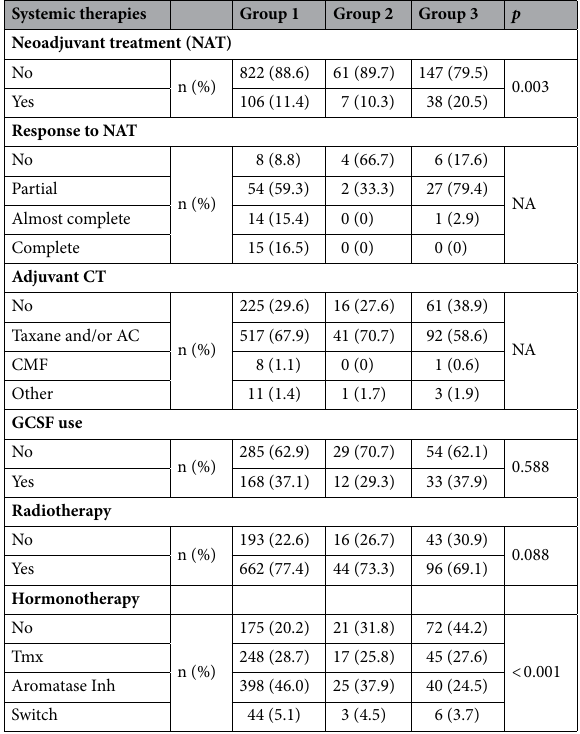
Table 3. Adjuvant and neoadjuvant treatment of the groups. NA not available, CT chemotherapy.